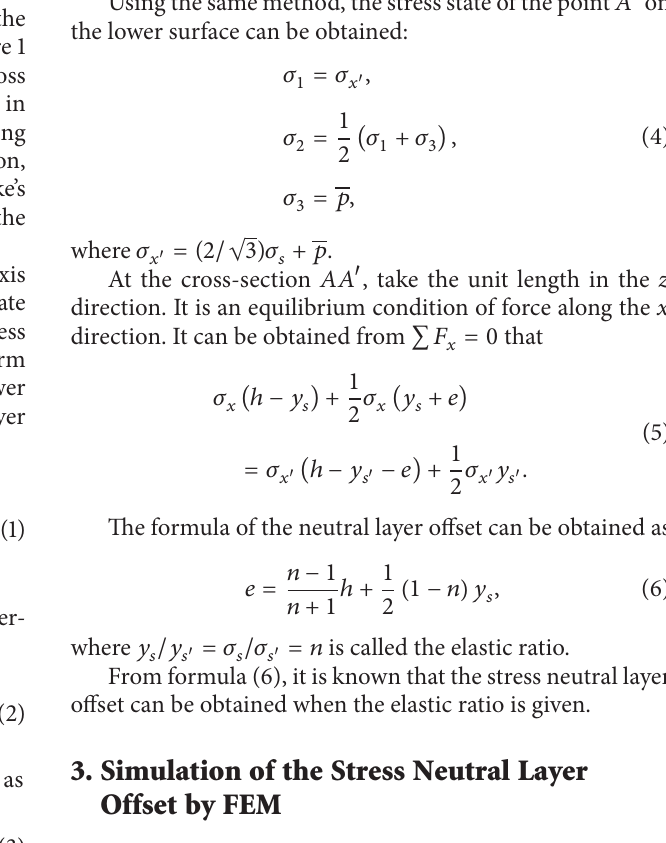
Figure 1: The traditional stress diagram in the cross section. (3) Plane Strain Assumption . The deformation of the plate along the width direction is neglected. The deformation zone is in a plane strain state.